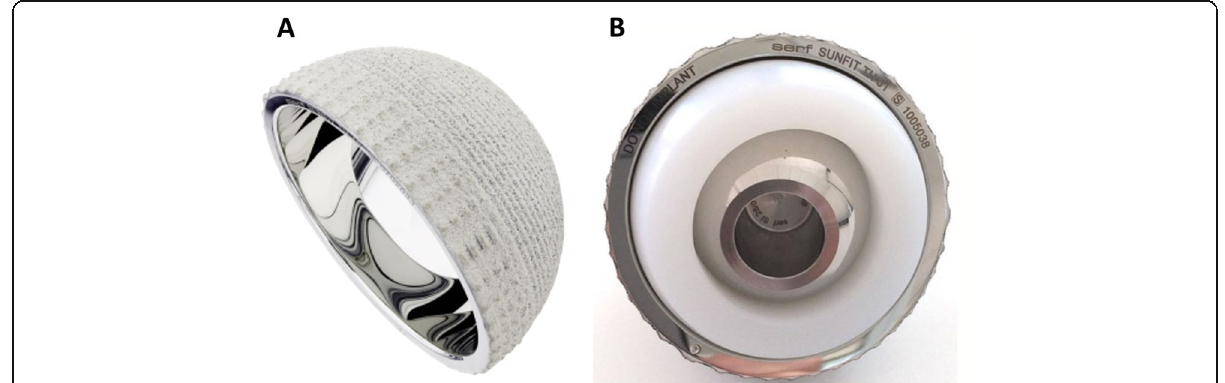
Fig. 1 The Novae Sunfit TH cementless dual mobility cup: ( a ) metallic shell with mirror-polished articular surface and rough porous outer surface coated with titanium and HA; ( b ) femoral head assembled with the retentive PE mobile insert that articulates within the metallic